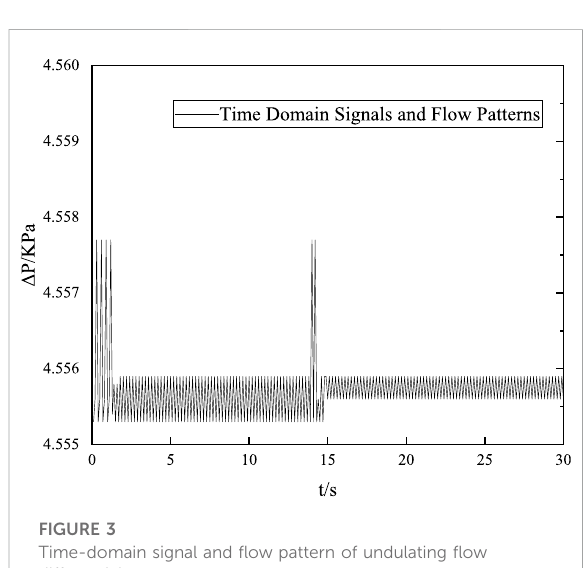
FIGURE 3 Time-domain signal and fl ow pattern of undulating fl ow differential pressure.